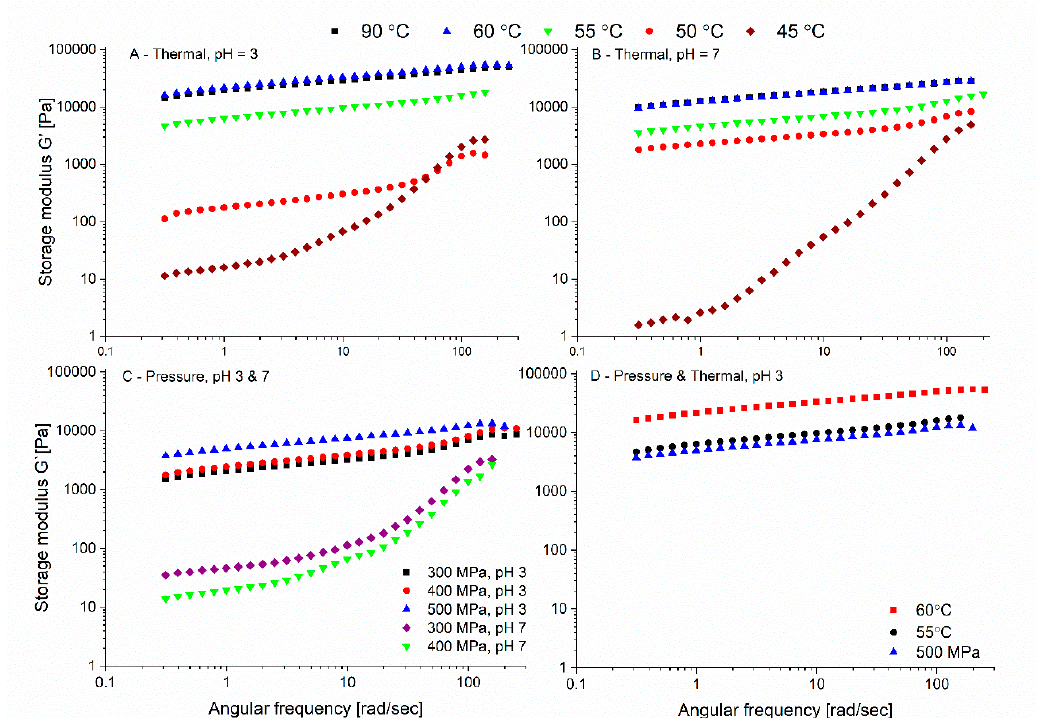
Figure 4. Storage modulus as a function of the angular frequency of potato protein isolate gels (10% w / w ) at pH = 3 and pH = 7. ( A , B ) thermal gelation at 90 °C, 60 °C, 55 °C, 50 °C, and 45 °C at pH = 3 and pH = 7, respectively. ( C ) Pressure-induced gelation at maximal pressures of 300, 400, and 500 MPa, buffer initial pH 3 and 7. ( D ) Comparison between the pressure-induced gel formed at pH 3 at 500 MPa to thermally formed gels (60 °C and 55 °C).